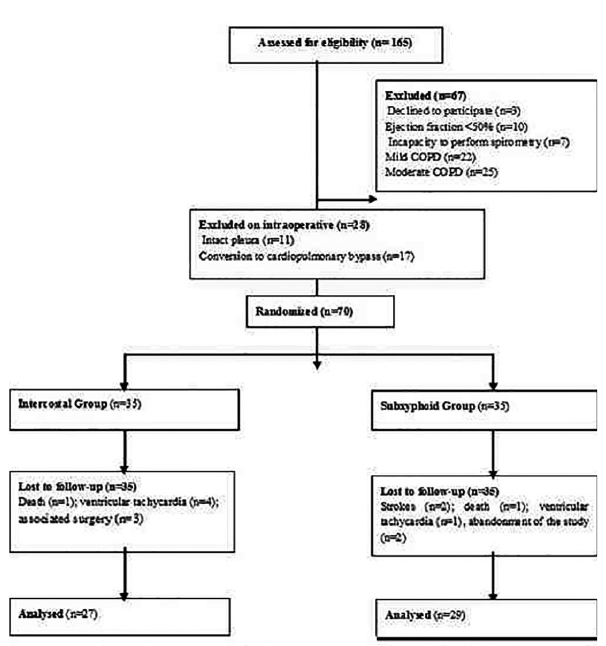
Fig. 1 - Flow diagram of the progress through the phases of a randomized trial. Table 2. Baseline patient